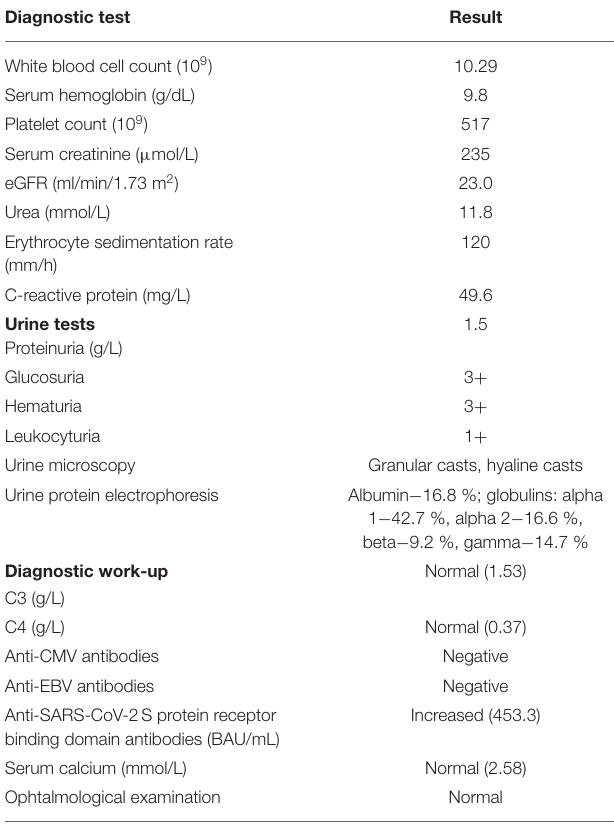
TABLE 1 | Laboratory findings at diagnostic work-up at the time of